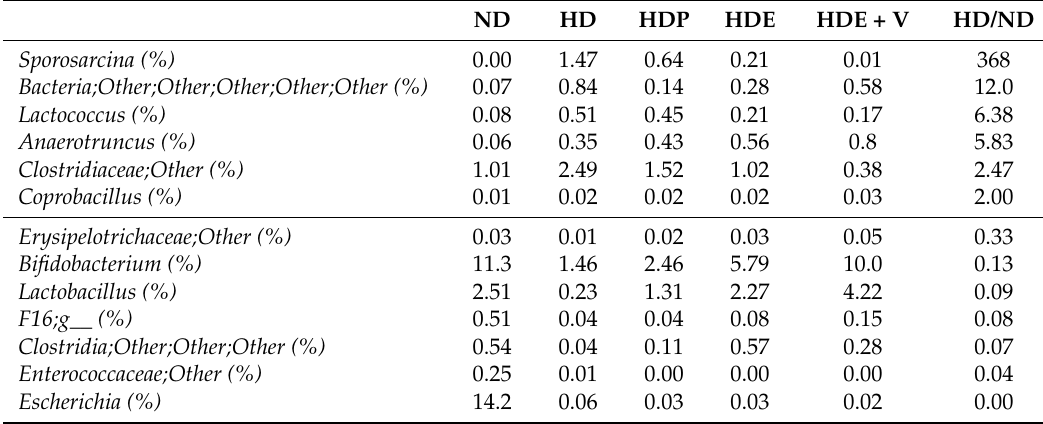
Table 6. Gut microbiota (genus level) that increased by more than two times or decreased to 1/2 or less in the HD group compared to the ND